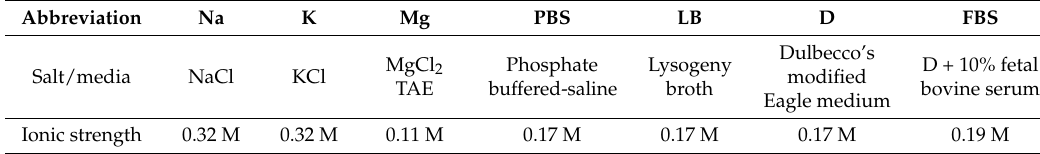
Table 1. Buffer solutions and biological media including their ionic